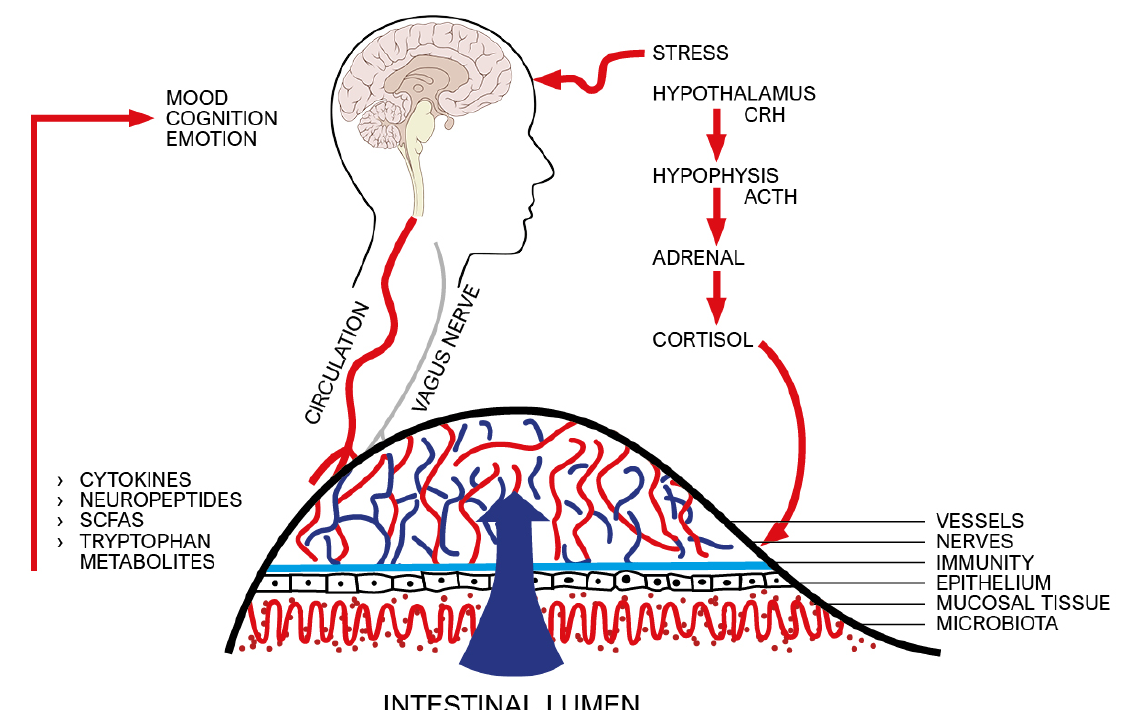
Figure 4. The physiological stress response is activated by physical environmental factors (such as heat and cold, humidity and drought, wind, noise, and pollutants), as well as by endogenous factors (such as a significant reduction in blood pressure and volume of circulating blood, body hydration and nutrition, as well as an infection or a hemorrhage), but also by emotional or cognitive factors [58]. The paraventricular hypothalamic nucleus (PVN) is the cerebral structure that activates the stress response. It is divided into three sectors: magnocellular, which releases oxytocin and arginine vasopressin; parvocellular, which releases corticotropin ‐ releasing hormone (CRH); and the neurons projected towards the brain stem, where the nuclei activating the sympathetic nervous system are located. CRH, a 41 amino acid molecule, is the activator of the neuroendocrine stress pathway, with ultimate production of cortisol from the fasciculate area of the adrenal cortex. The PVN is under the control of cortical circuits, particularly of medial prefrontal cortex, and subcortical circuits, particu ‐ larly of bed nucleus of the stria terminalis (BNST), hippocampus, and amygdala. Animal research and brain imaging studies in humans have documented that CRH production is controlled by acti ‐ vating and inhibitory circuits through the release of glutamate and GABA, respectively. PVN is directly excited by afferents from the brainstem and hypothalamic circuits, whereas afferents from the prefrontal cortex and hippocampus inhibit the HPA axis, via BNST GABA ‐ ergic projections [59]. For four decades, the molecular mechanism by which CRH is raised under stress has been known. Activation of neural pathways afferent to CRH neurons in the PVN causes a rapid calcium influx that stimulates the fusion of CRH ‐ containing vesicles to the cell membrane and subsequent release CRH [60]. Figure shows that emotional stress, through the cortisol release from adrenal cortex, can disrupt the intestinal barrier, causing dysbiosis and intestinal inflammation which in turn can reach the brain by altering mood and cognition. SCFA: short ‐ chain fatty acids.